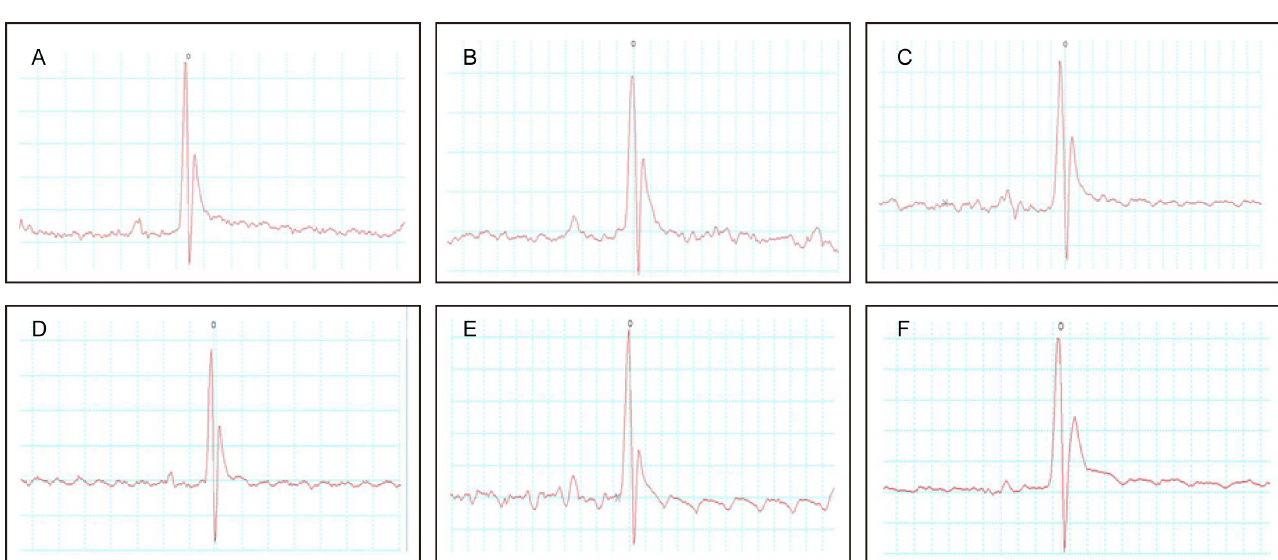
FIGURE 4 - Electrocardiogram recordings on day 21 day for mice injected intravenously on alternate days with : (A)sham, (B) DOX+SS, (C)DOX + PSO-PLN (3 mg/kg), (D)DOX+PSO-PLN (6 mg/kg), (E)DOX+PSO-PLN (9 mg/kg), (F)DOX.